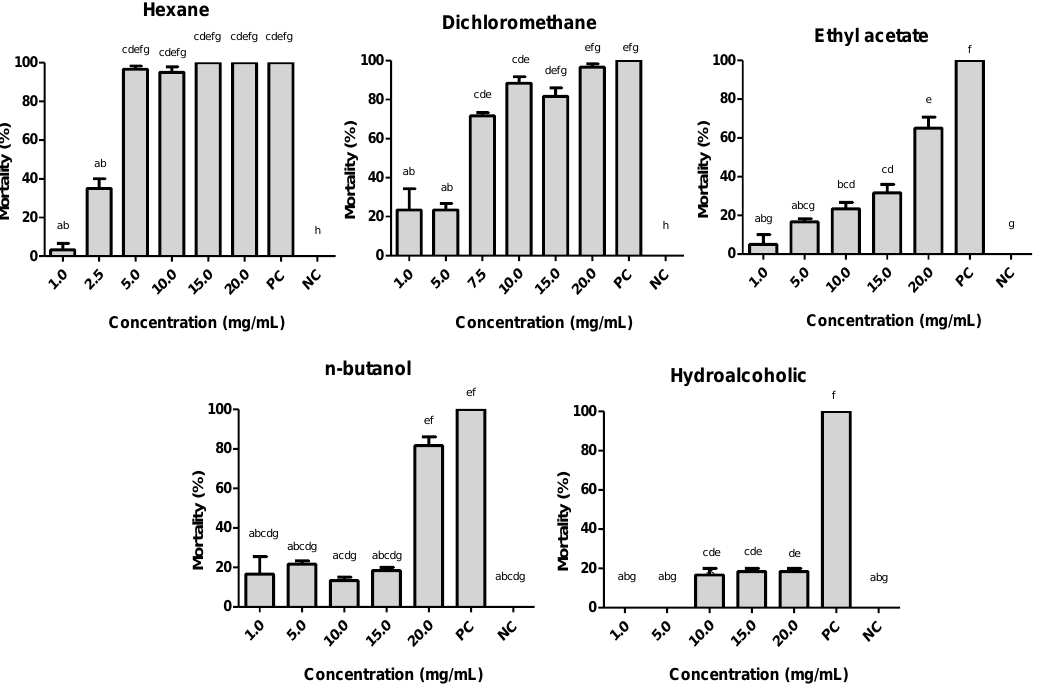
Figure 1. Larvicidal activity of Helicteres velutina fractions from crude ethanolic extract (CEE) against A. aegypti larvae. PC = positive control, NC = negative control. Bars with the same letter are not significantly di ff erent as determined by Tukey test, 5%.